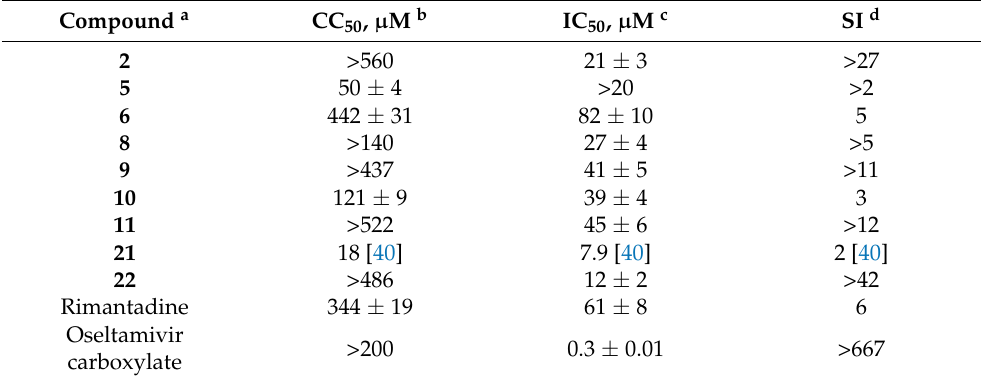
Table 1. The antiviral activity of compounds 2 , 5 , 6 , 8–11 , and 22 against influenza virus A/Puerto Rico/8/34